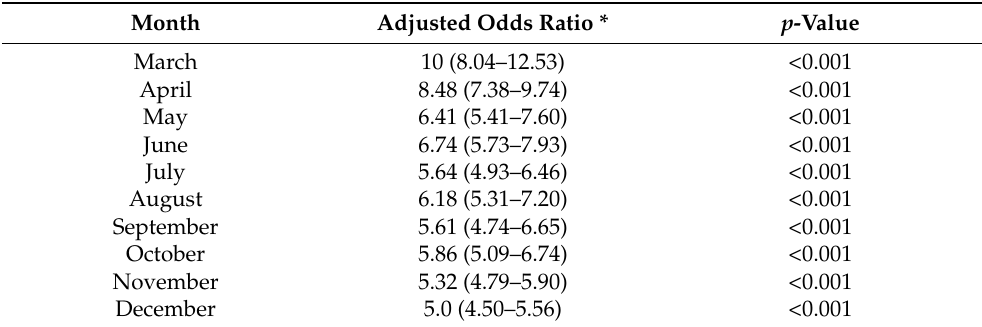
Table 4. Monthly Mortality Adjusted Odds Ratio of Acute CHF with COVID-19 compared to Acute CHF patients without